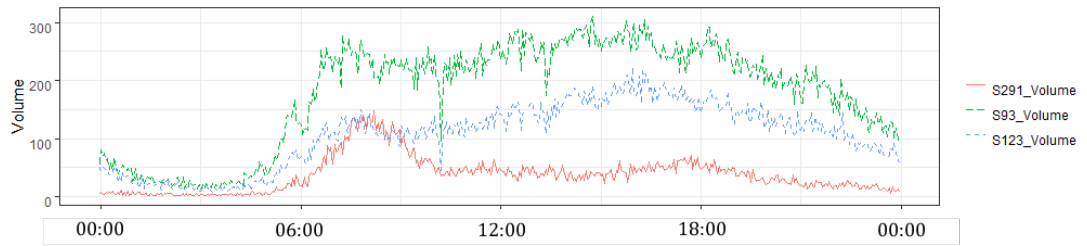
Figure 3. Typical daily tra ffi c at three sensor locations (S291, S93, and S123). We executed the research separately for original time series of tra ffi c volume and detrended